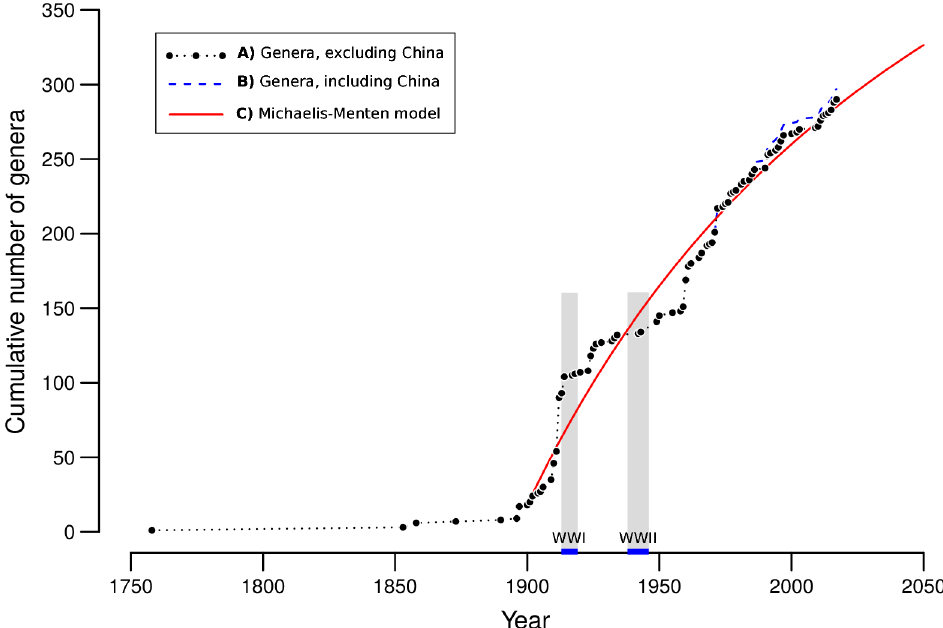
Fig 2 . Cumulative number of termite genera since Linnaeus (1758). A) number of genera, excluding China; B) number of genera, including China; C) Michaelis-Menten model fitted on curve A. WWI: World War I (1914-1918); WWII: World War II